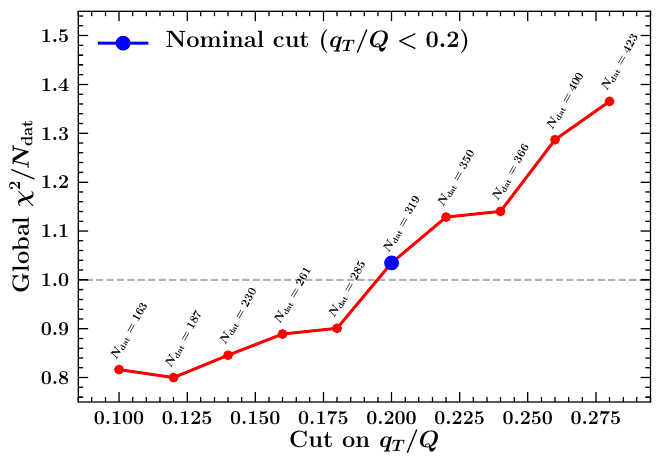
Figure 8 . The global (cid:31) 2 =N dat as a function of the cut on q T =Q . The blue point corresponds to the reference cut used in this